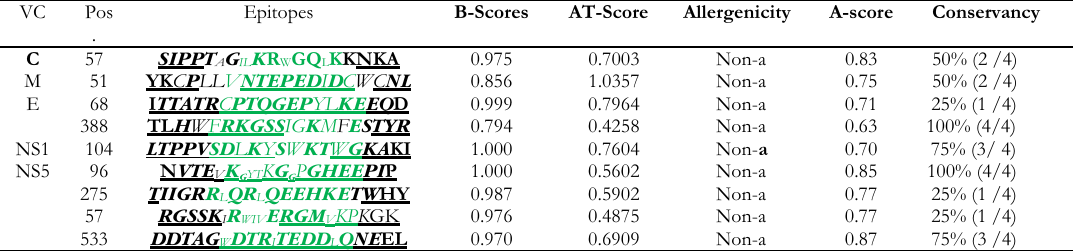
Table 5. Selected B-cell epitopes. The B-cell epitopes were predicted using BCPREDS web-based tool and were validated by BepiPred 2.0 software. Epitopes are represented as BCPREDS predicted. Green colored epitopes were predicted by BepiPred. Additionally, underlined amino acids are structurally coiled whereas the amino acids (not underlined) are structurally helix. For surface accessibility, subscripted amino acids are buried as against the exposed amino acids. VC viral component; Pos. position; B-score BCPred score, A-score ABCpred score, AT-score antigenicity score. For antigenicity prediction, the threshold was set to 0.4, which implies that any predicted epitope with antigenicity score ≥ 0.4 is said to be antigenic. In addition, regions of the B-cell epitopes predicted by SVMTrip with a score of 1.00 were italicized.